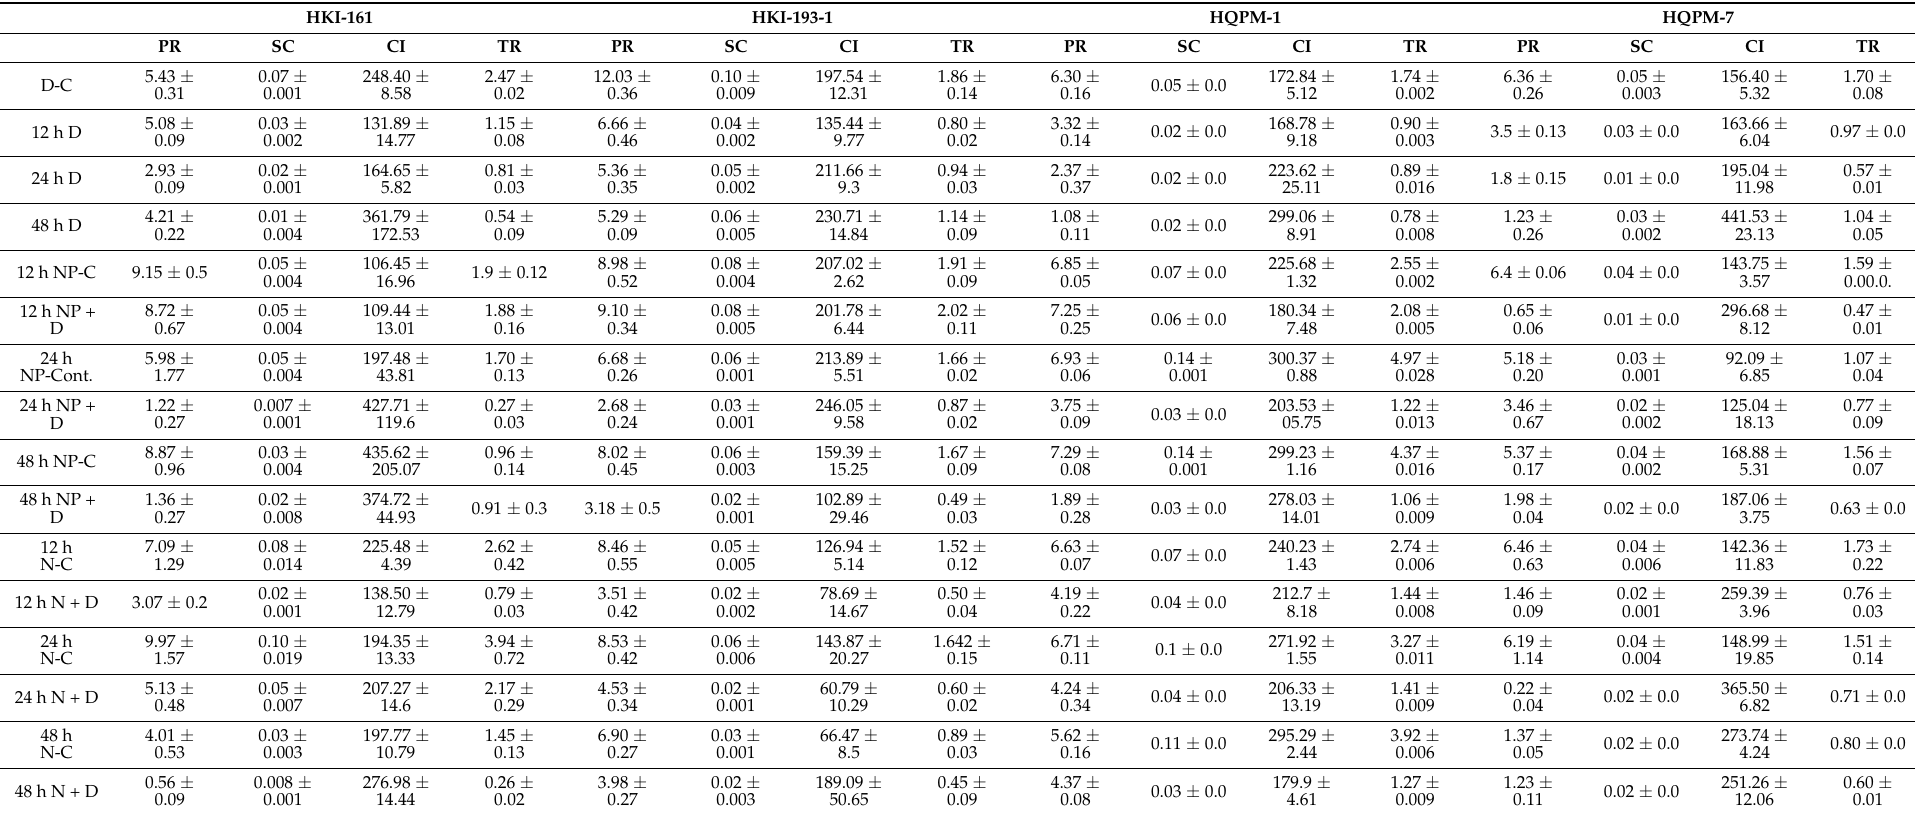
Table 1. The effect of drought stress with and without N, P and NP pre-supplementation on the photosynthetic parameters of maize seedlings as measured by the using a portable open-flow gas exchange system (LI-6400,